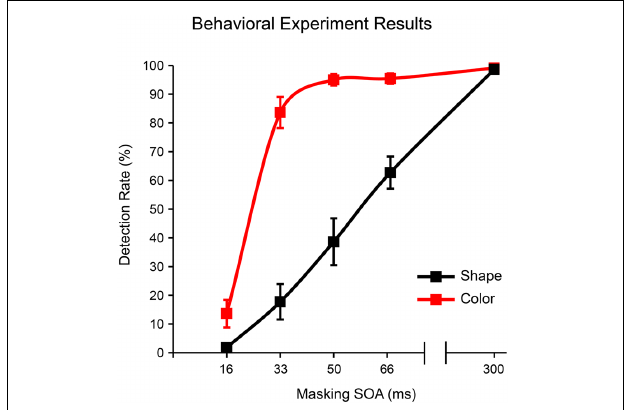
FIGURE 4 | Detection rates as a function of masking SOA for shape (square) and color (4-red-lines) stimuli in the behavioral experiment. Error bars reflect the standard error of the mean